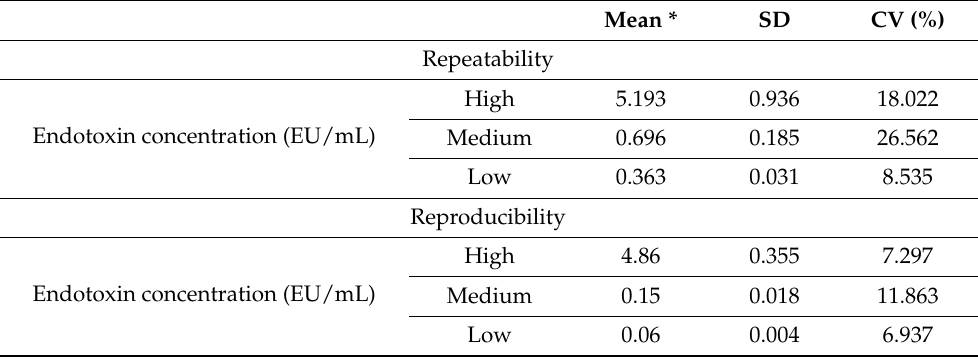
Table 3. Validation of the kinetic turbidimetric Limulus amebocyte lysate (LAL) assay for endotoxin quantification in milk matrix using samples in the high, medium, and low concentration range: repeatability and reproducibility.